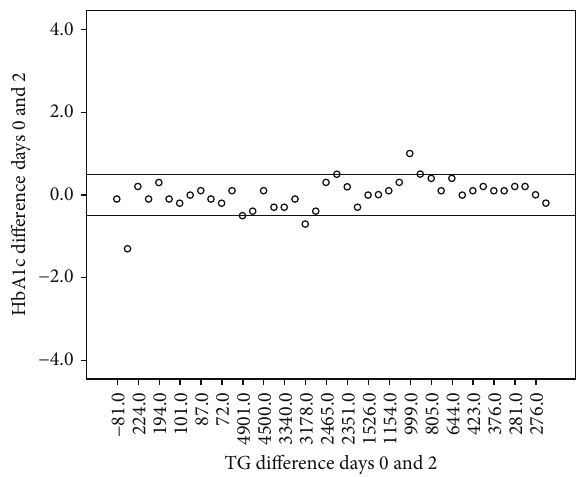
Figure 1: Di ff erences between days 0 and 2 of HbA1c and triglycerides. TG: triglycerides. N = 43 . Spearman nonparametric correlation (Spearman correlation coefficient = 0 265 , p = 0 015